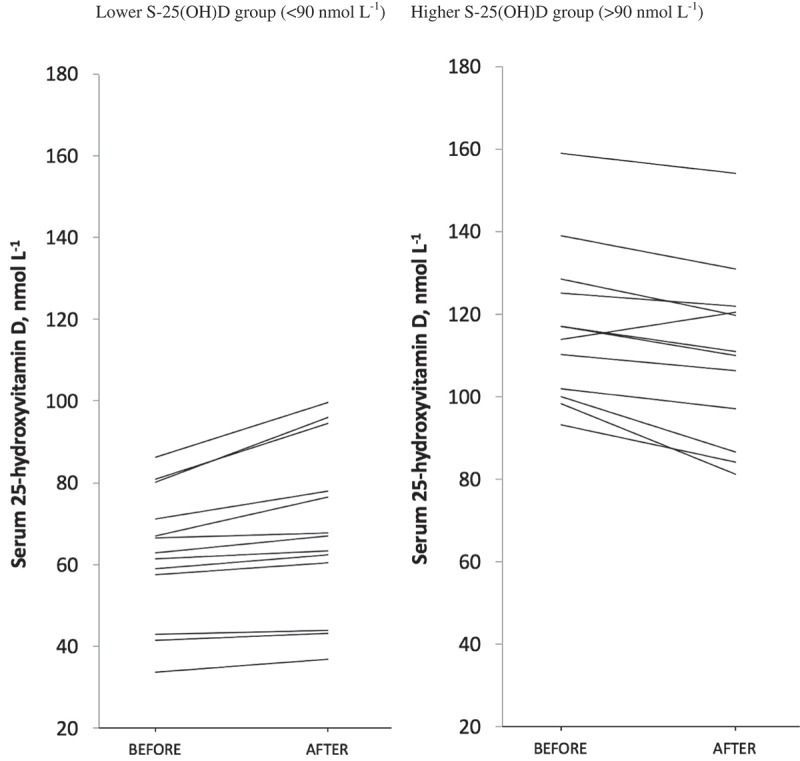
Changes in S-25(OH)D concentrations in the lower S-25(OH)D group (<90 nmol/L) and in the higher S-25(OH)D group (>90 nmol/L).